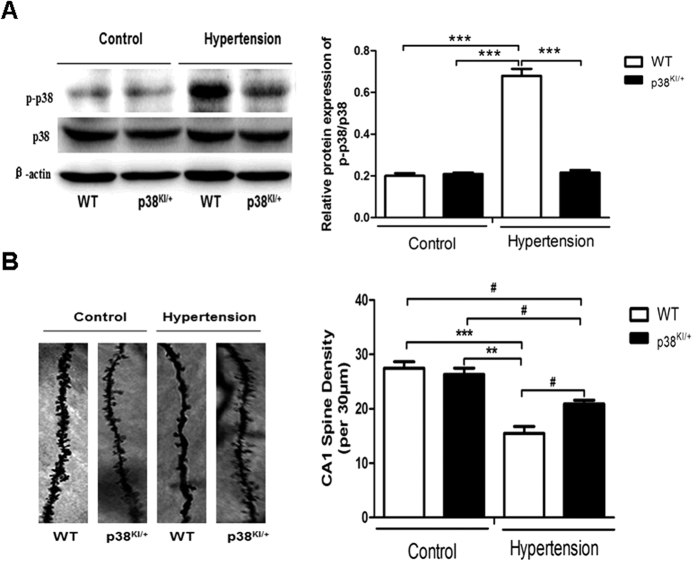
p38 MAPK knockdown increases dendritic spine number on hippocampal CA1 pyramidal cells.(A) WT and p38KI/+ mice were subjected to hypertension surgery at 9 weeks of age. Four wks post-surgery, western blotting was performed on the hippocampal lysates.Right bar graph shows quantification of p38 MAPK phosphorylation in hippocampus, n = 3 mice per experimental group. (B) Representative Golgi stain image. Right bar graph shows quantification of dendritic spine density, n = 3, and five neurons per mouse were analyzed. Data are presented as mean ± SEM. ***p < 0.001, **p < 0.01, #p < 0.05 by one-way ANOVA with Bonferroni post-test.